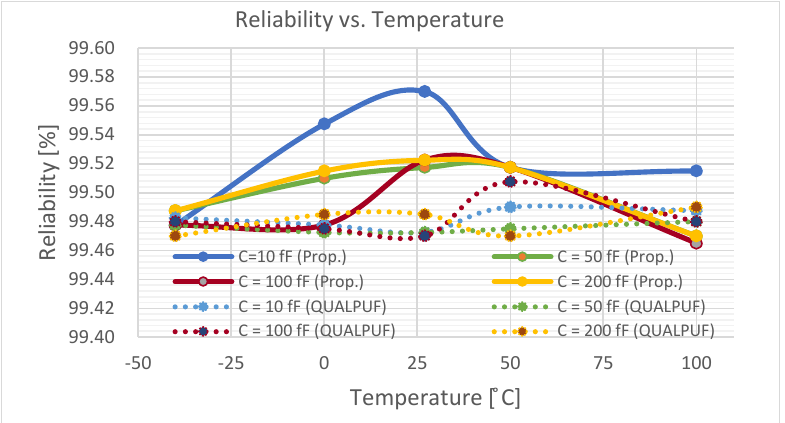
Figure 8. Uniqueness of the proposed FinFET-based TPCA-PUF (labeled as Prop.) versus QUAL-PUF under the V TH variation (4-bit PUF).